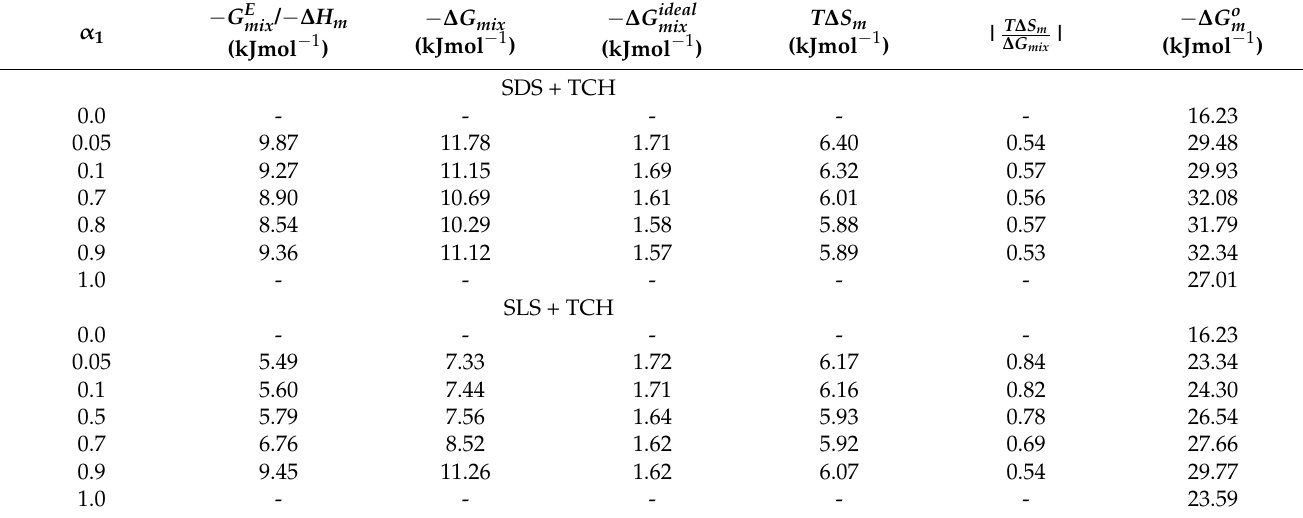
Table 2. Energetic constraints of TCH + SDS/SLS mixtures in aqueous NaCl a